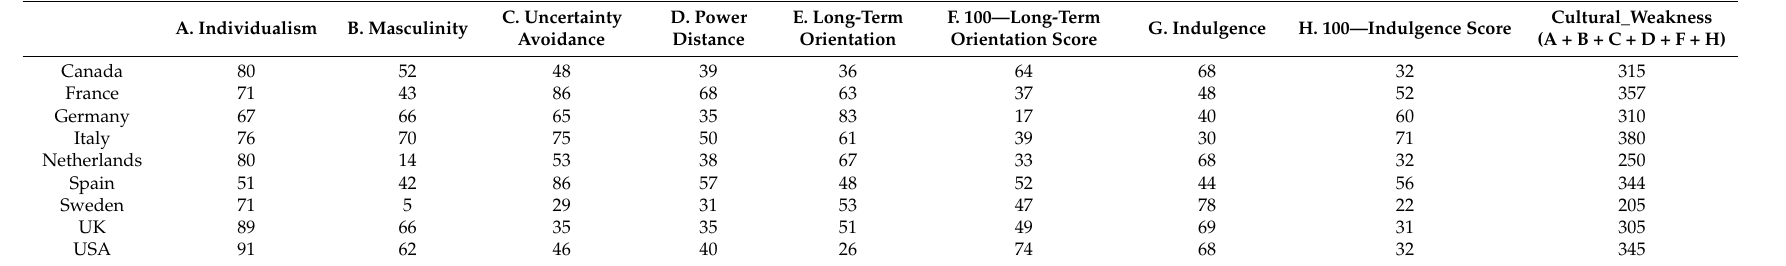
Table 3. Scores of Hofstede’s dimensions by